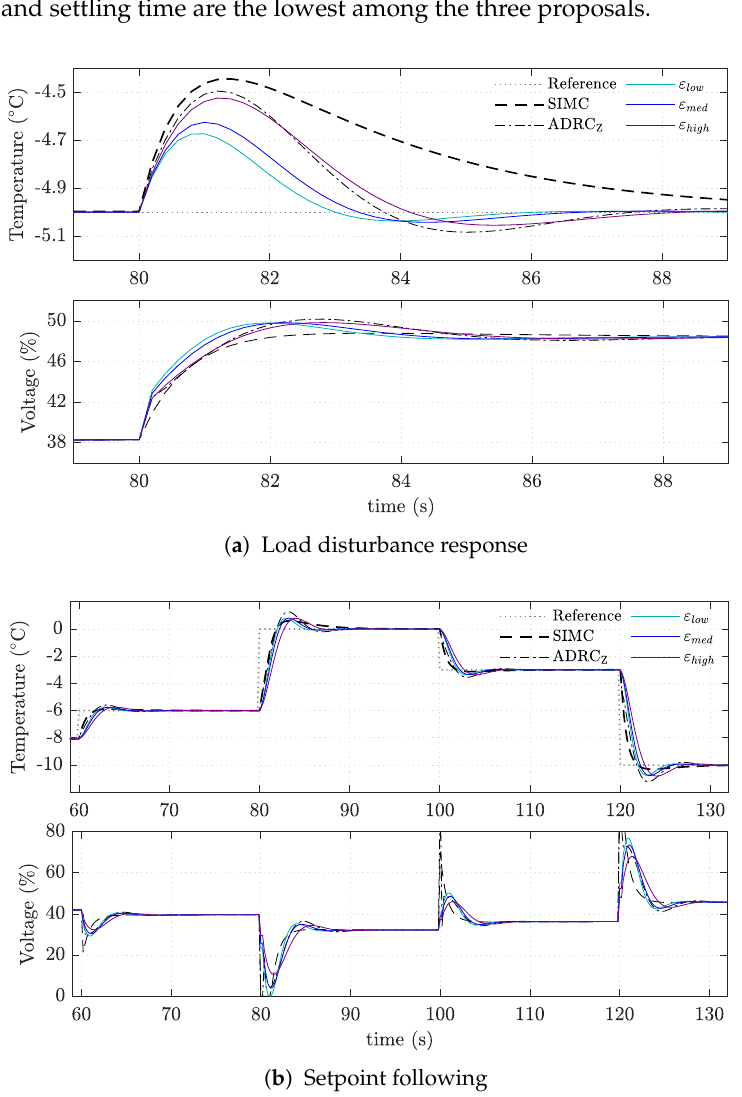
Figure 17. Closed loop time response of the Peltier thermoelectric module with the second-order LADRC tuned with the proposed rules. Comparison with the performance of ADRC Z and SIMC con-